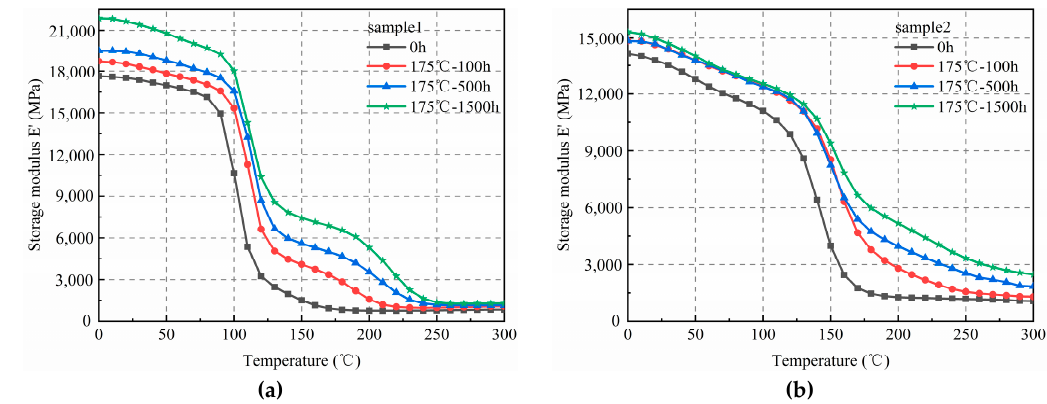
Figure 4 The elasticity modulus of EMC under different aging times (temperature = 175 °C). (a)Sample 1; (b)Sample 2.